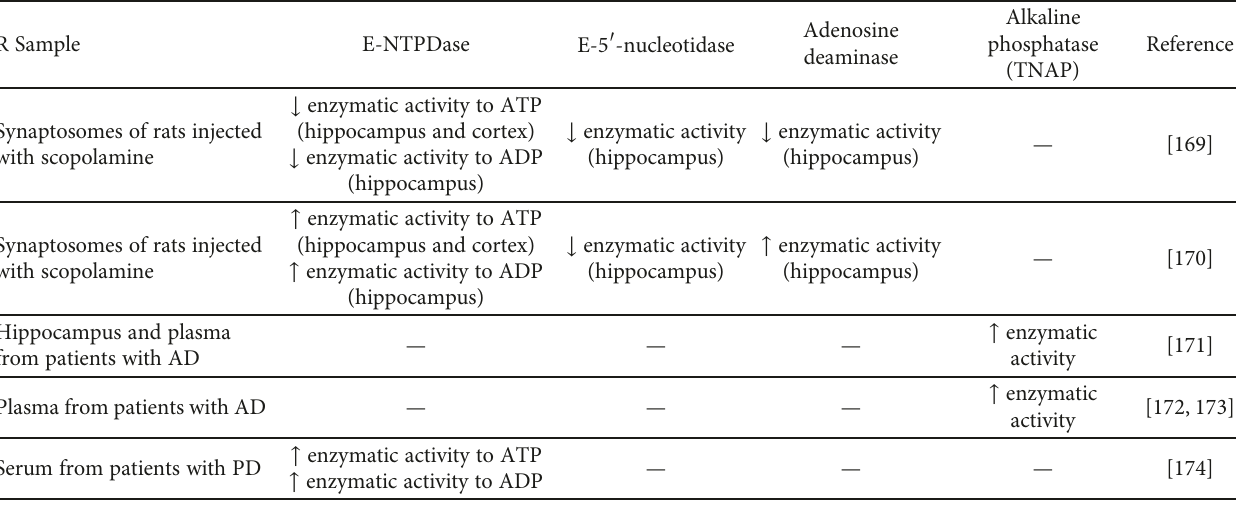
Table 4: Ectonucleotidases (E-NTPDase, E-5 ′ -nucleotidase, and adenosine deaminase) in experimental models and patients with Alzheimer ’ s disease (AD) and Parkinson ’ s disease